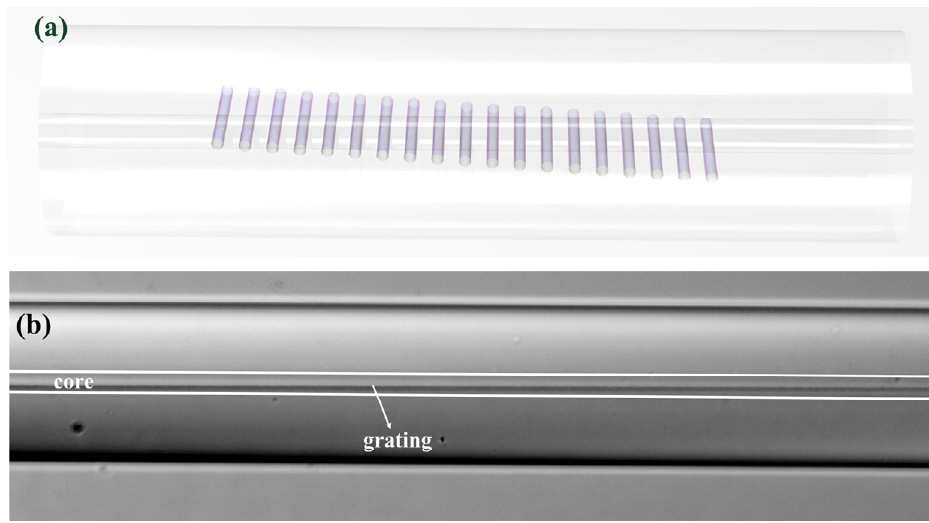
Figure 7. ( a ) Schematic of apodized LBL-FBG. ( b ) Microscopy (10×) of apodized LBL-FBG. The transmission and reflection spectrum of the apodized LBL-FBG (measured in air with a high-resolution sweep frequency system) is given in Figure 8a,b. For comparison, a nonapodized LBL-FBG (length: 1319.31 µ m) with the same resonance intensity (17 dB) as the apodized one was fabricated. With the proposed apodization method, cladding mode coupling could also be controlled. As Figure 8a shows, LP 0n and LP 1n cladding mode coupling occurs at the same time, but resonance intensity is extremely low compared with the nonapodized one, and the grouping characteristics are not observed. The sidelobe is evidently suppressed, as the reflection spectrum demonstrates. The Bragg peak to the first sidelobe was only 1.824 dB in the nonapodized LBL-FBG, but the value increased, to 6.1 dB in the apodized counterpart. The method proposed here is proved to be effective in apodization of FBG and cladding mode coupling can also be suppressed. This apodization method also does not induce any polarization dependency to the grating. Figure 9 illus- trates the transmission spectra of the apodized LBL-FBG under two different polarization states (we select two extreme conditions). The birefringence effect is not obvious in this kind of situation and polarization state induces little effect on the apodized